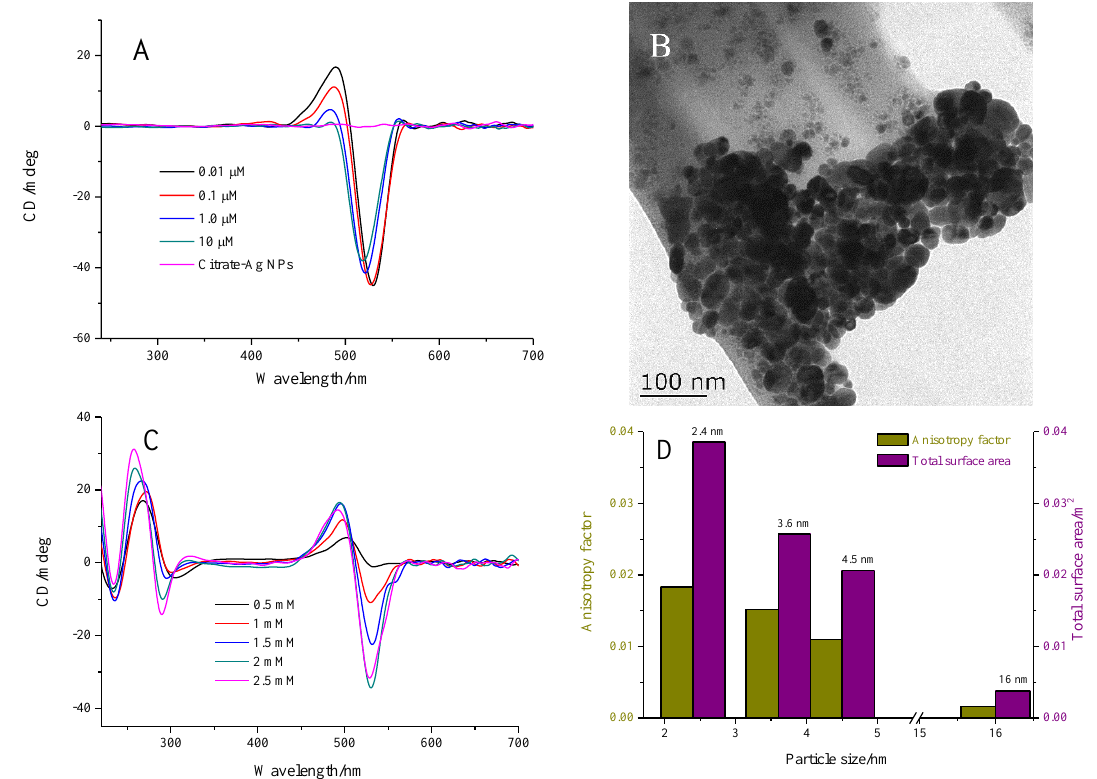
Figure 4. ( A ) The evolutions of circular dichroism (CD) spectra of L -Cys capped Ag nanoparticles (NPs) with the varied concentration of L -Cys; ( B ) The transmission electron microscopy (TEM) image of the aggregated L -Cys capped Ag NPs; ( C ) The evolutions of CD spectra of L -Cys capped Ag NPs with the varied concentration of L -Cys; ( D ) The relationship between the anisotropy factors and the total surface areas of L -Cys capped Ag NPs with the varied particle sizes.